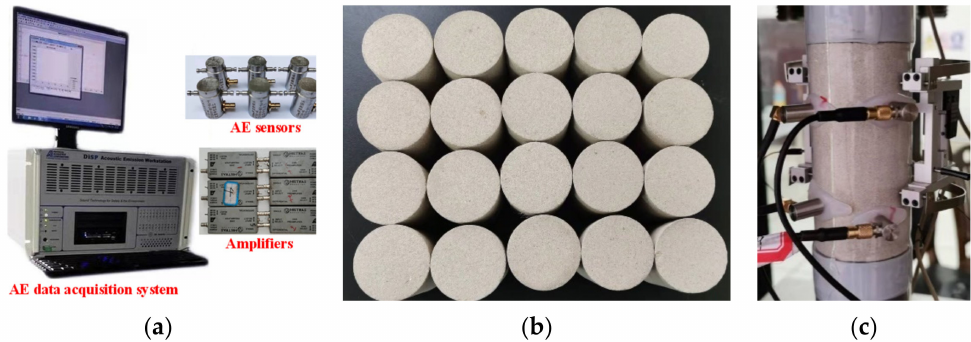
Figure 6. AE instrument and sample setup. ( a ) PCI-2 AE equipment; ( b ) sandstone samples; and ( c ) sample setup.